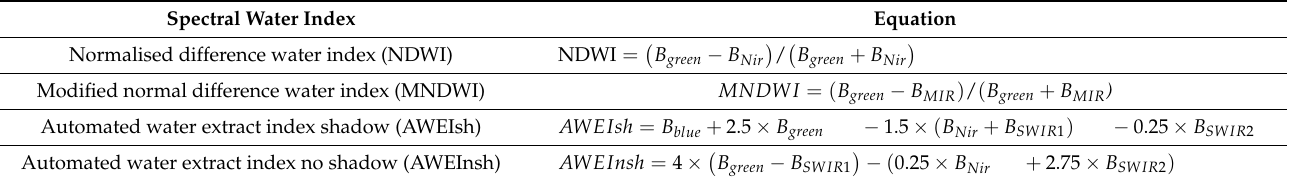
Table 2. Spectral water indices for water feature